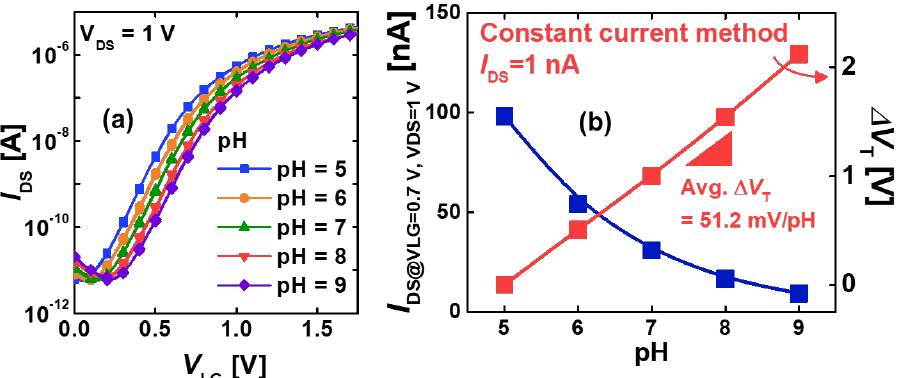
Figure 9. ( a ) Transfer characteristics of SiNW FETs with varying pH values. ( b ) the pH-dependencies of the drain-to-source current ( I DS ) and Δ V T in SiNW FETs. The sensitivity of Δ V T = 51.2 mV/pH was comparable to the Nernst